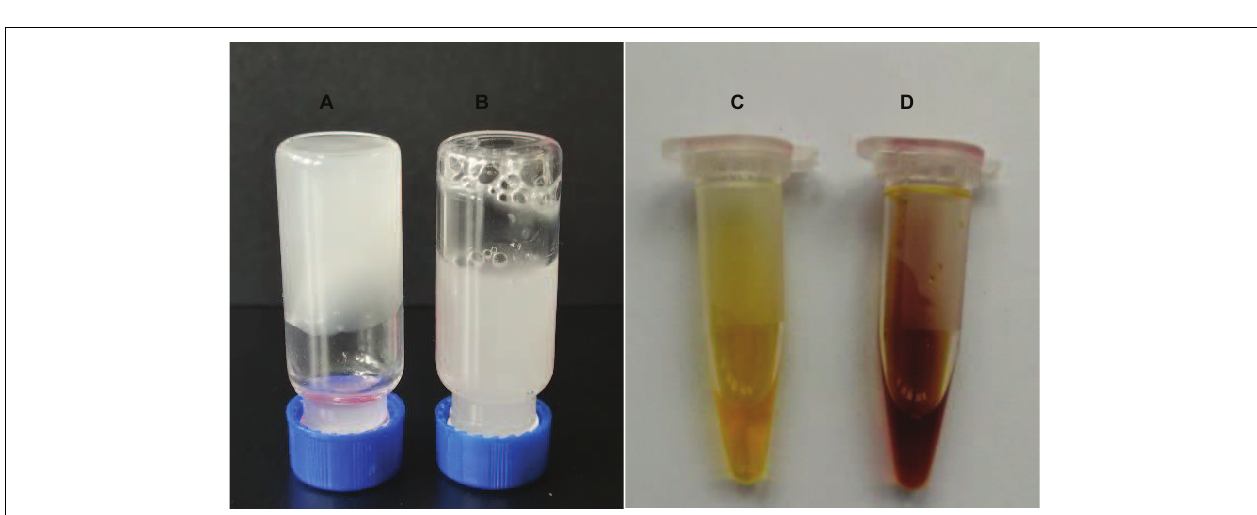
FIGURE 5 | Activity analysis of WelR in vitro . Photographs of 0.5% (w/v) welan gum solution after 10 h of reaction without WelR (A) and treated with DNS developing reagent (C) (blank control); with WelR (B) and treated with DNS developing reagent (D) .